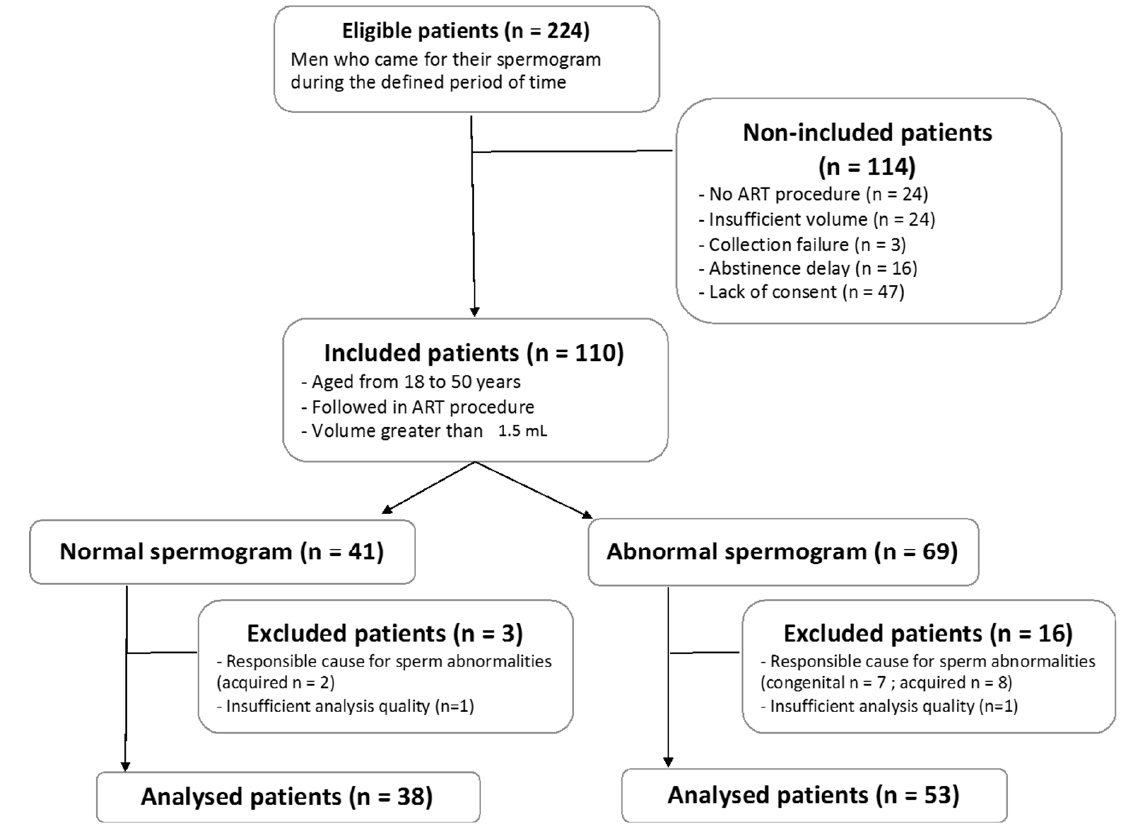
Figure 1. Flow chart of the study population. ART = assisted reproduction technique.